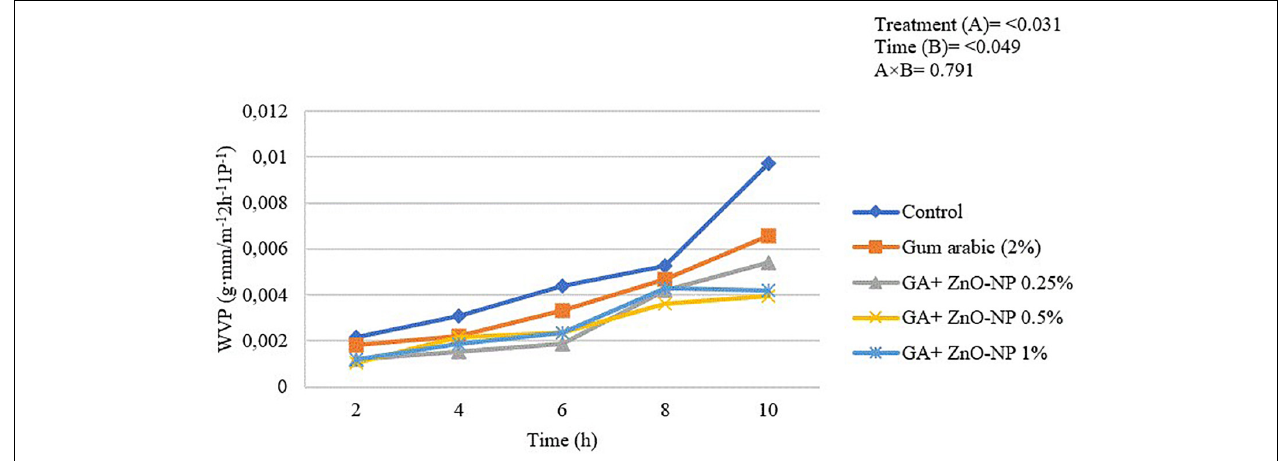
FIGURE 2 | Water vapor permeability of ‘Kinnow’ mandarin rinds for 10 h. Error bars denote the standard error (SE) of the mean. Means ± standard errors presented. To determine the interaction effects, factorial ANOVA was performed for the main factors, treatment, and time. GA + ZnO-NP, gum arabic + zinc oxide nanoparticles; WVP, water vapor